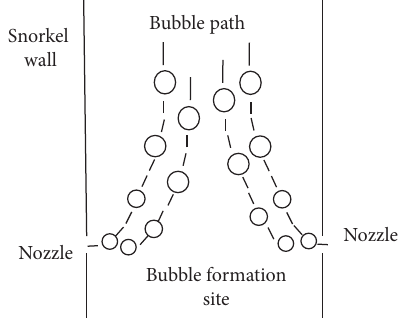
Figure 3: Schematic of the formation and path of bubbles in